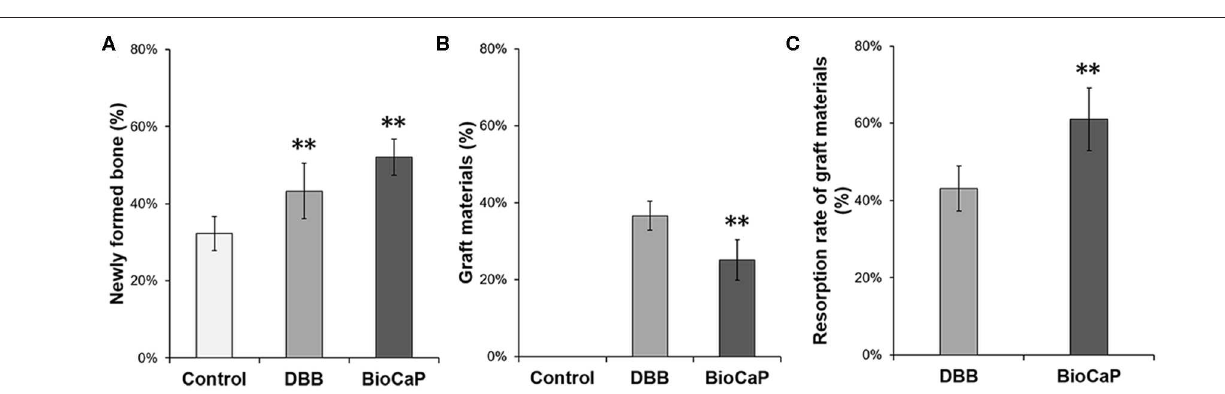
FIGURE 3 | BioCaP grafting enhanced bone formation and degradation of graft material. (A) Percentage of newly formed bone at week 8. (B) Percentage of remaining graft materials at week 8. (C) The resorption rate of graft materials at week 8. Data are presented as mean ± SD, from six independent experiments. Significant effect of the treatment, ** p <